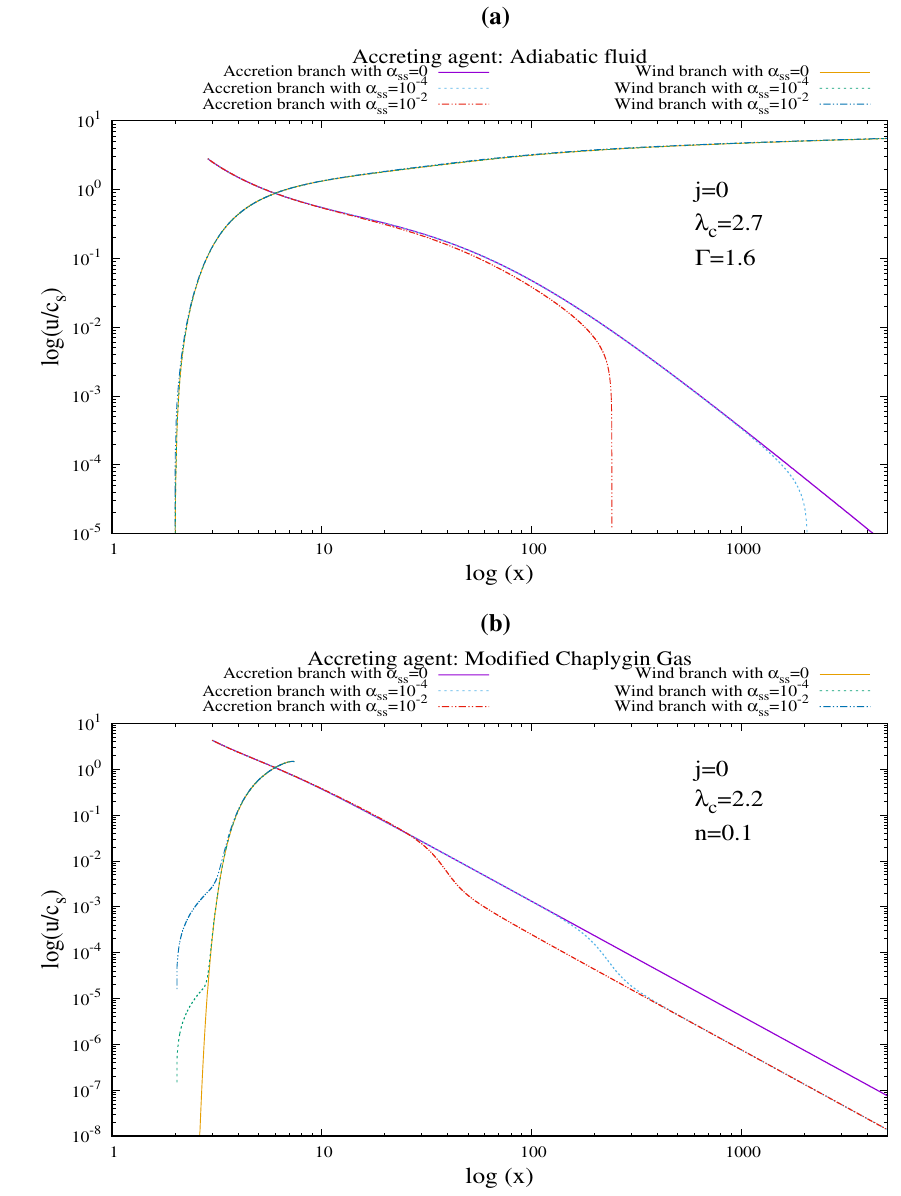
batic black hole accretions shows both accretion and wind’s decrease as we move far from the black ratio of λ λ k